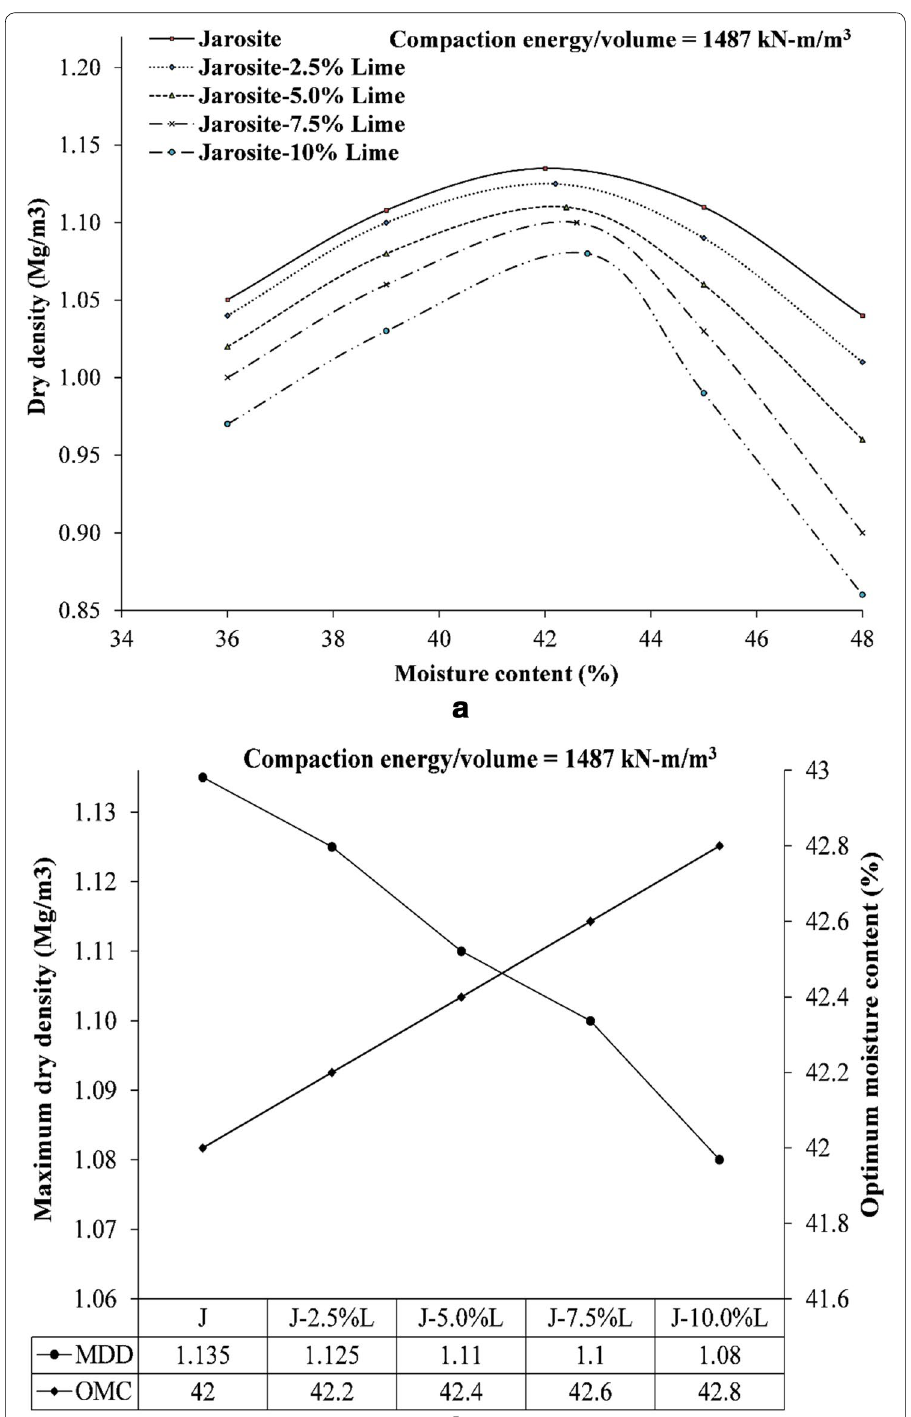
Fig. 3 Effect of lime content on a dry density and moisture content; b maximum dry density and optimum moisture